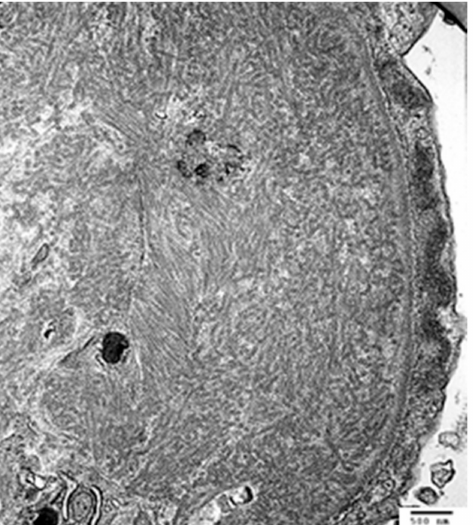
Figure 6. Immunotactoid glomerulopathy, with monoclonal Ig deposits with large microtubular sub- structure, hollow cores, arranged in focally parallel arrays (mesangial deposits, direct mag 18,000 ×